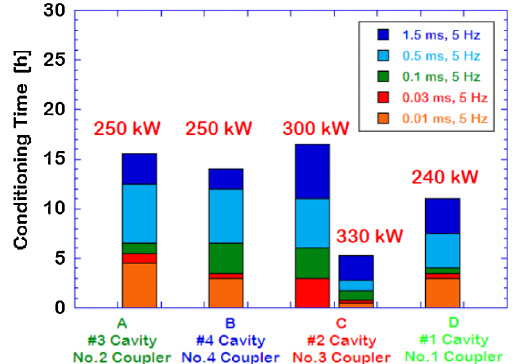
FIG. 11. (Color) Conditioning time for four input couplers in cryomodule under total reflection condition (standing wave mode).